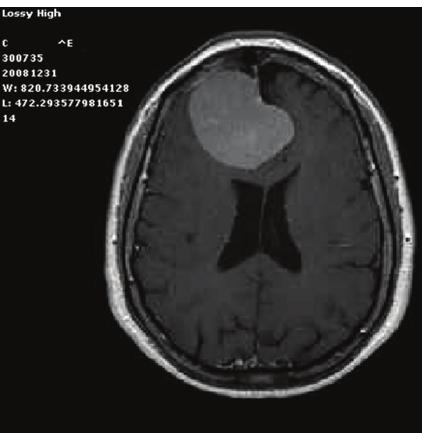
Figure 1: Preoperative contrast-enhanced axial MRI of the right frontal falx meningioma.